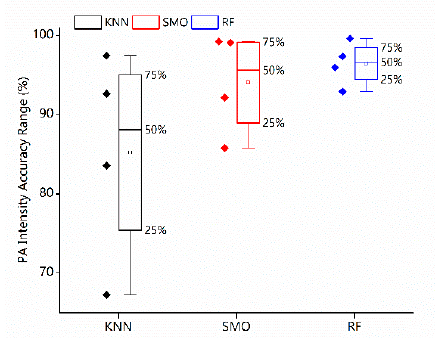
Figure 7. Statistical distributions of the first layer classification results.